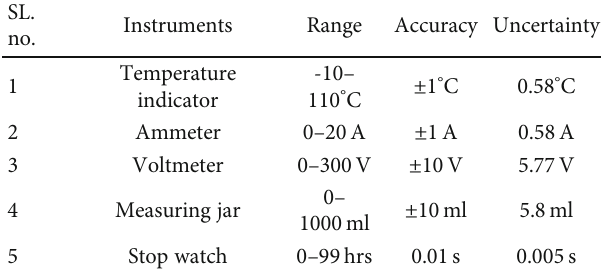
Table 1: Uncertainty of measuring instruments.